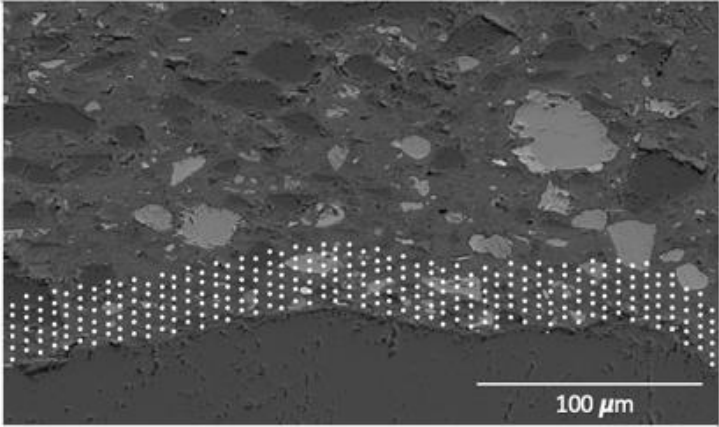
Figure 9. Example of the spot analysis on the paste to define the C-A-S-H composition.